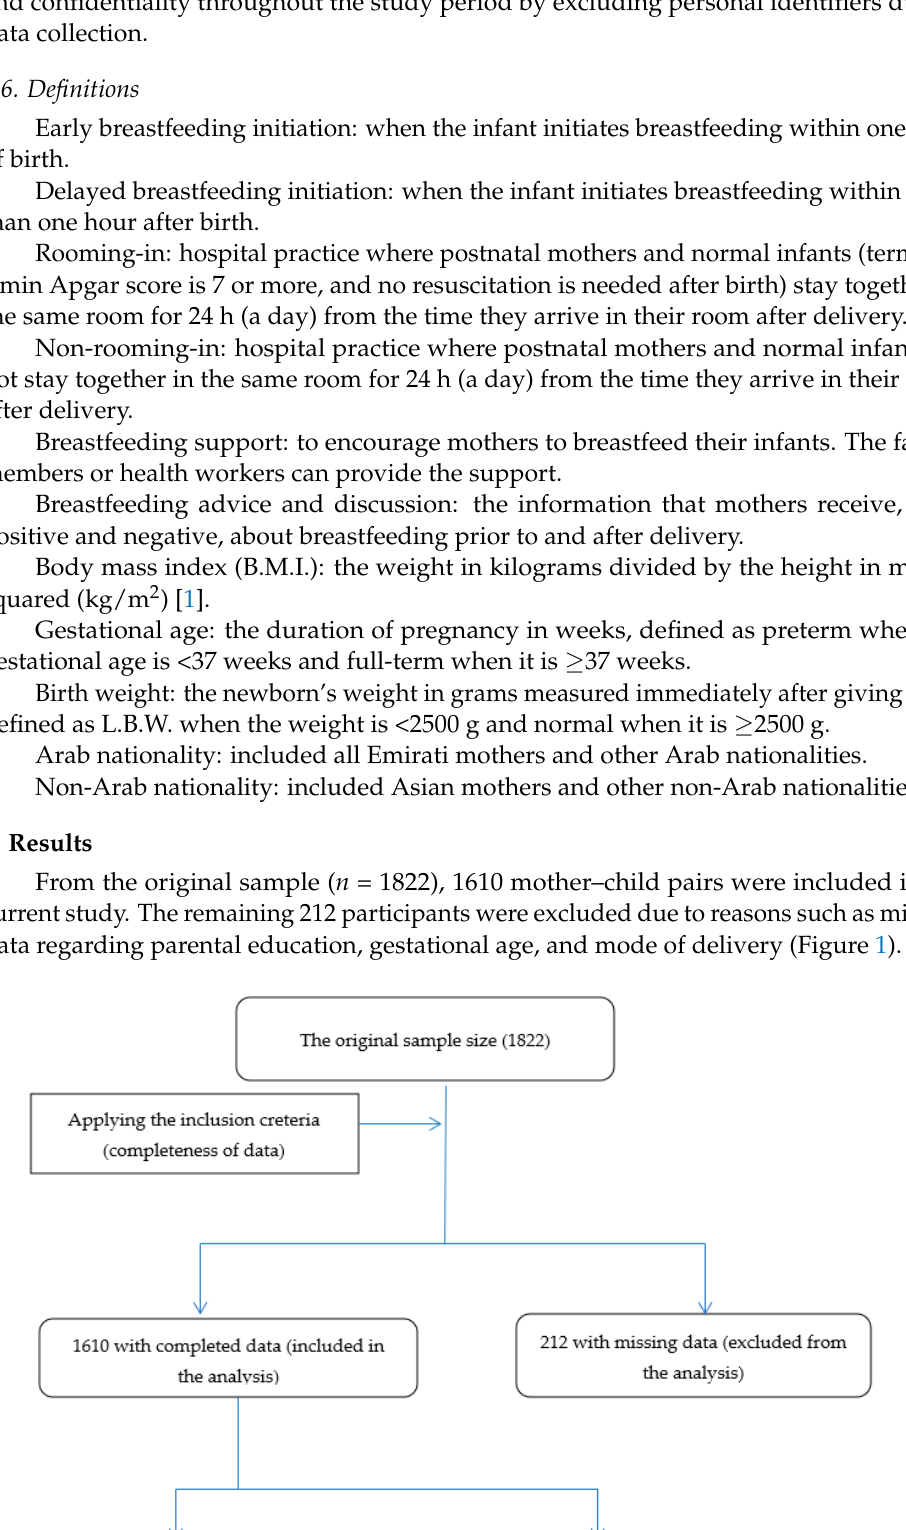
Table 1. Mean (S.D.) of the sociodemographic characteristics of the participants ( n = 1610) using t -